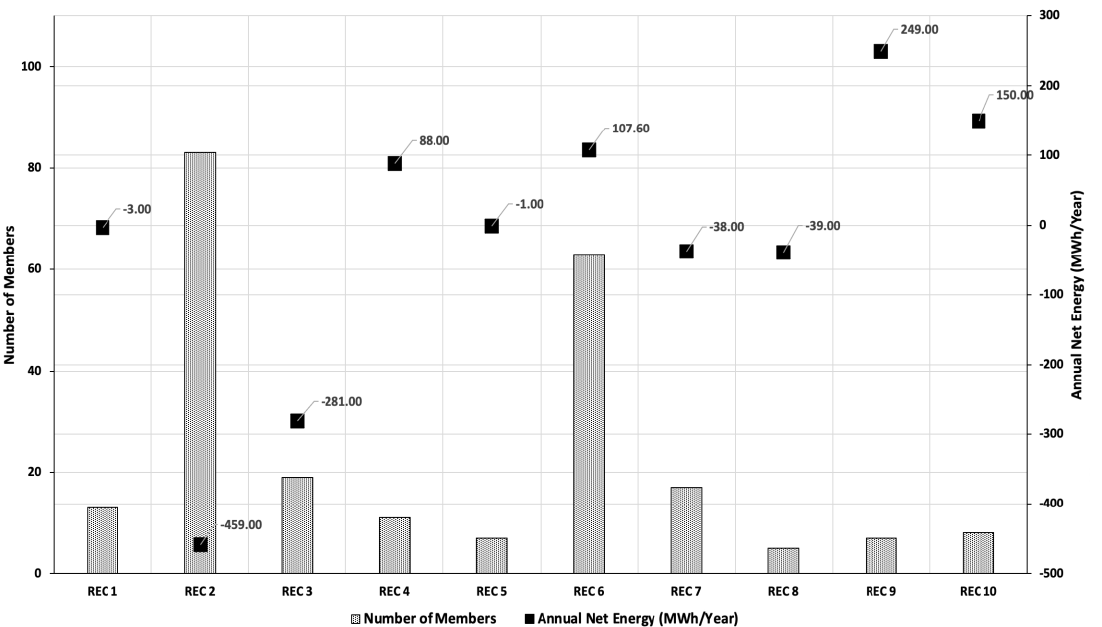
Figure 21. Number of members and annual net energy by REC — average-link.